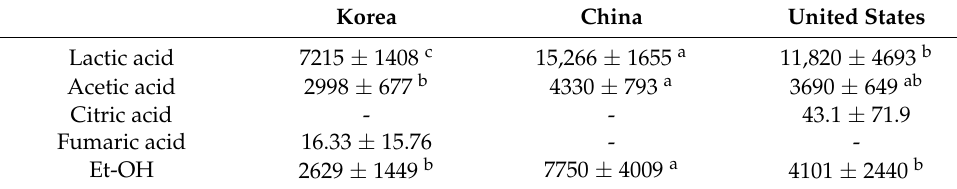
Table 4. Organic acid contents of commercial kimchi manufactured in Korea, China, and the United States